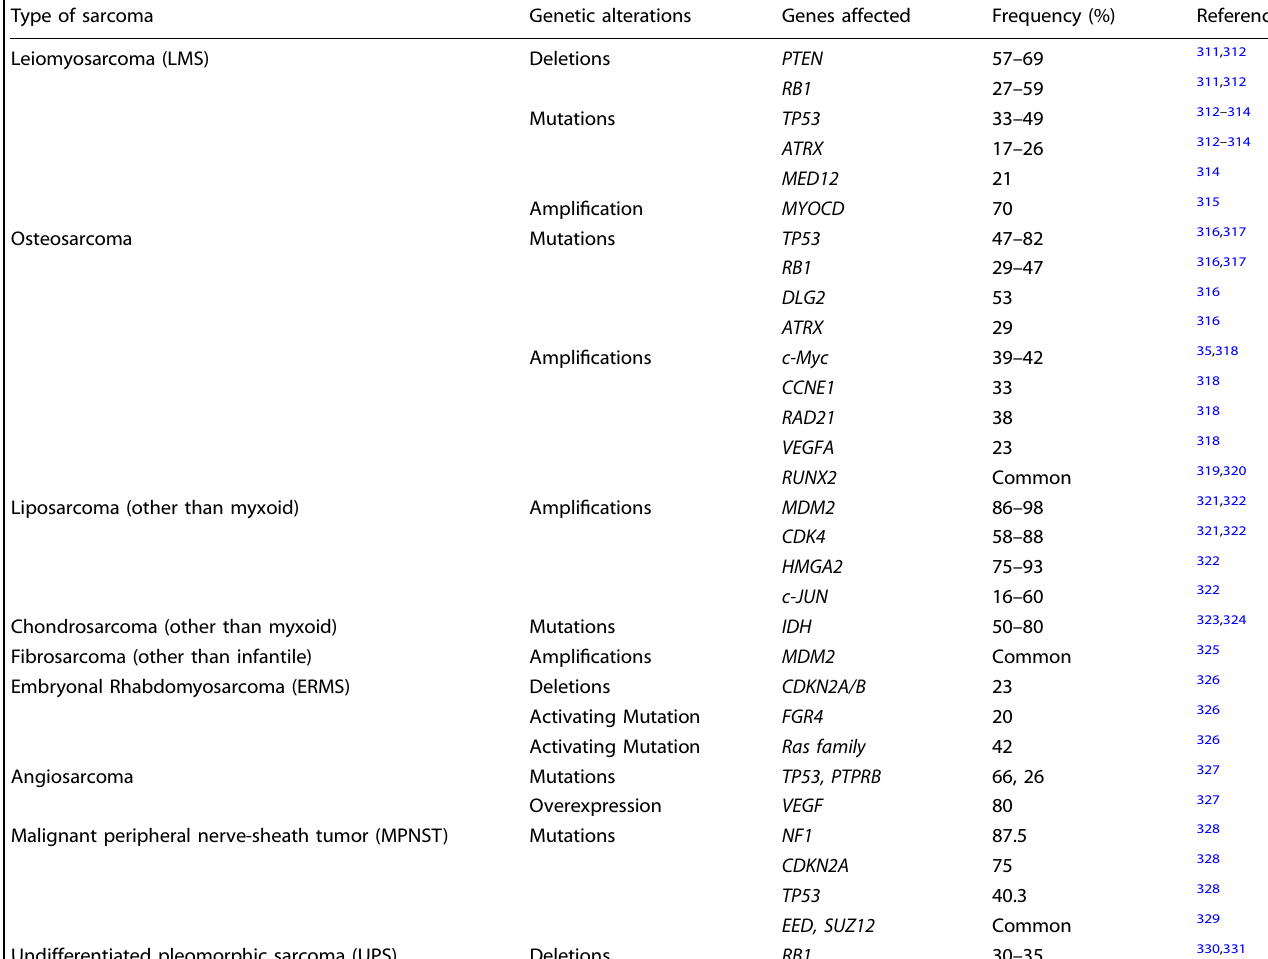
Table 2. Frequent genetic alterations observed in sarcomas with complex karyotypes Type of sarcoma Genetic